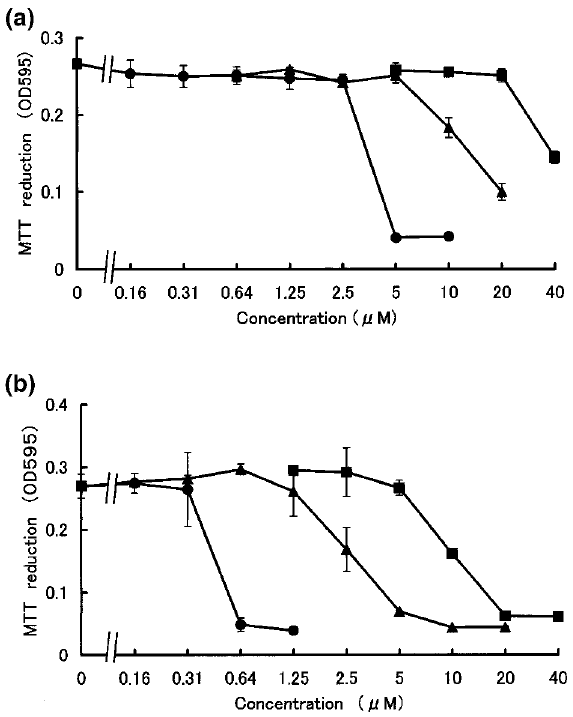
FIG. 1. Effect of rhMRP8, rhMRP14 or MRP8/MRP14 complex on the number of EL-4 cells. Cells were cultured with the indicated concentrations of ( j ) rhMRP8, ( m ) rhMRP14, or ( d ) an equimolar mixture in (a) standard RPMI-1640 medium or (b) in divalent-cation-depleted medium for 40h. Cell num- bers were estimated by MTT reduction. Bars represent upper and lower values of duplicate estimations. When bars are not shown, they are smaller than the size of the